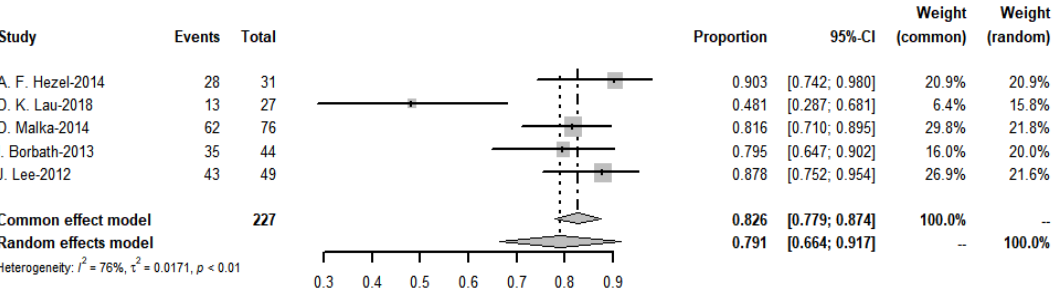
Figure 21. Disease control rate of immunotherapies and funnel plot.